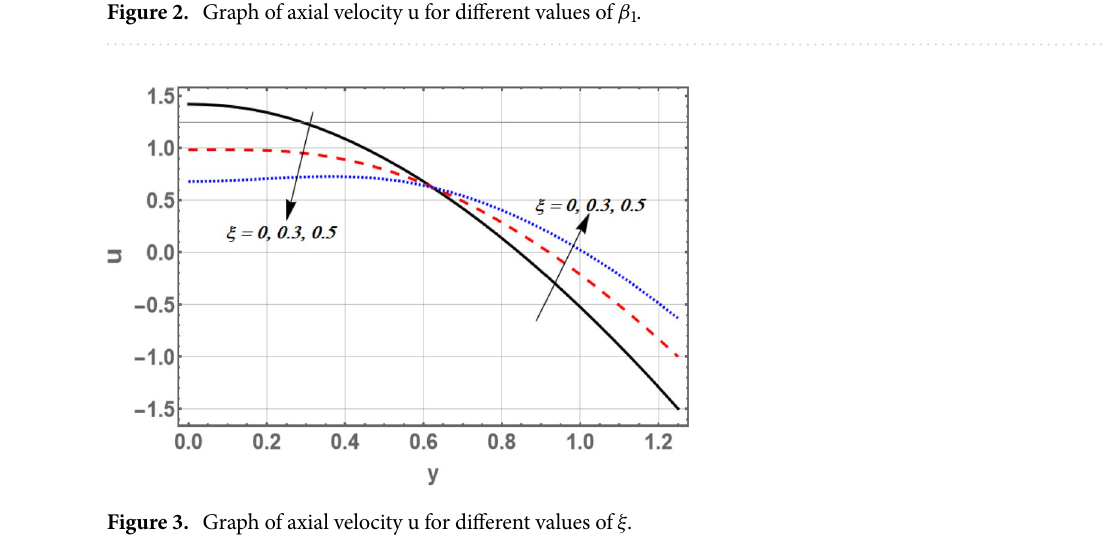
Figure 3. Graph of axial velocity u for different values of ξ